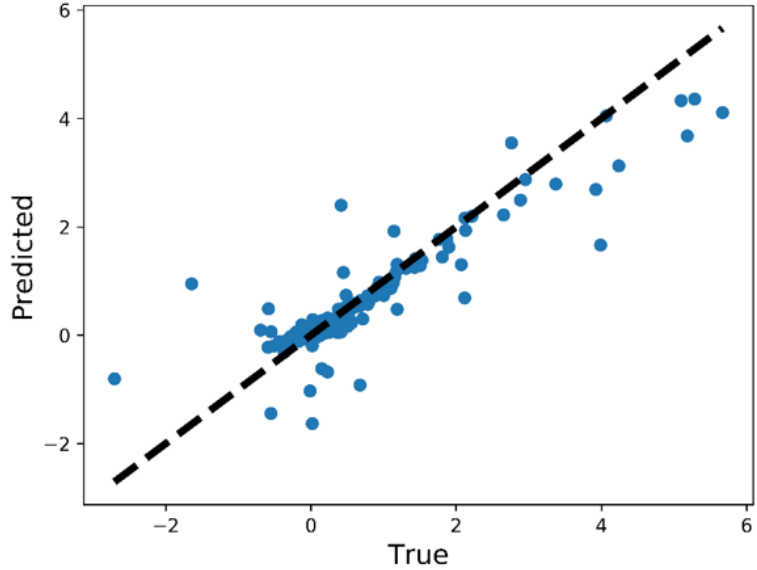
Figure 10. Performance of the trained model on the test set (synthetic shape).